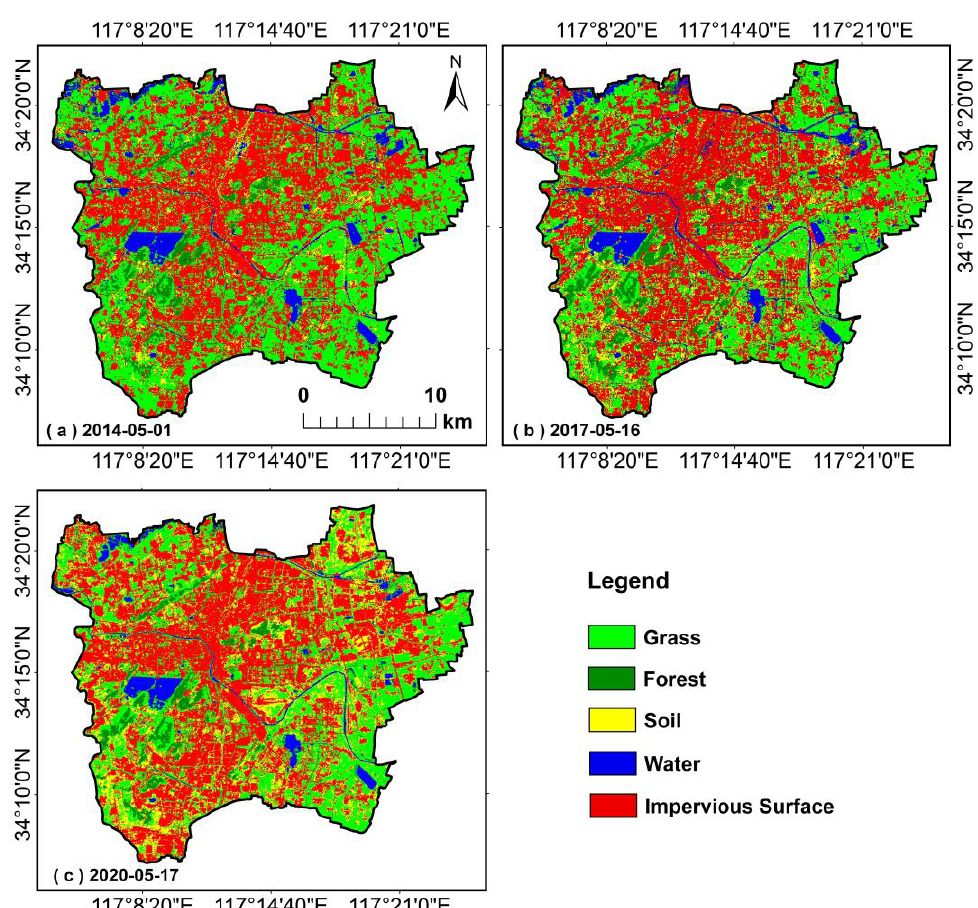
Figure A1. Land cover classification maps (resampled to 50 m): ( a ) 2014-05-01; ( b ) 2017-05-16; and